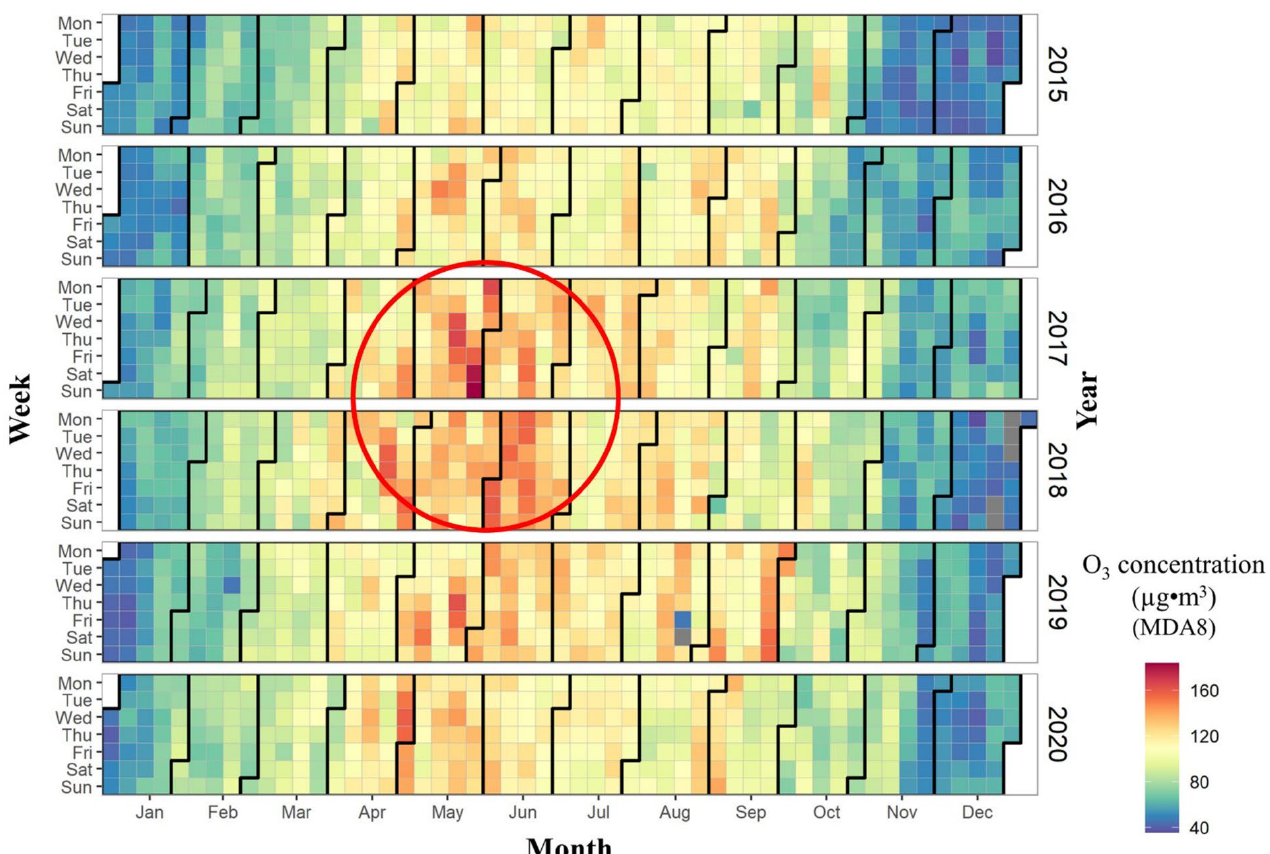
Figure 1. The heat map of urban O 3 concentration (MDA8) in mainland China from the year of 2015 to 2020. (The “grey” colour in Figure 1 represents the days when there were less than 14 valid MDA8 data and the MDA8 value did not exceed the limit value criteria between 08:00 and 24:00. Missing dates are 22–26 December 2018).